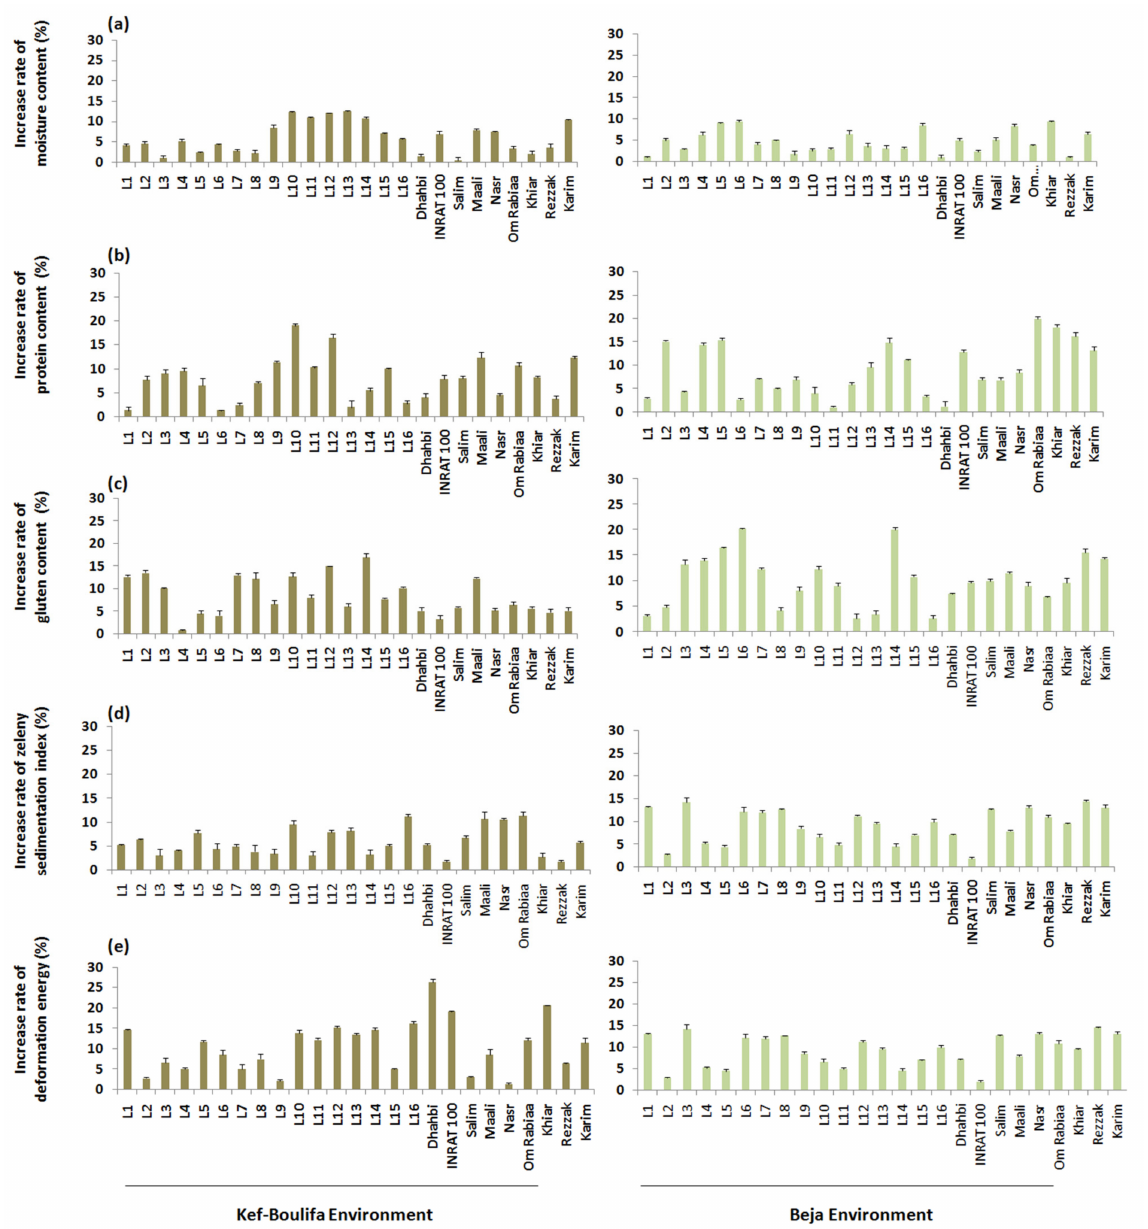
Figure 2. Increase rate of moisture ( a ), protein ( b ) and gluten ( c ) contents, Zeleny sedimentation index ( d ), and deformation energy ( e ) of 25 durum wheat cultivars after Se foliar supply across the two